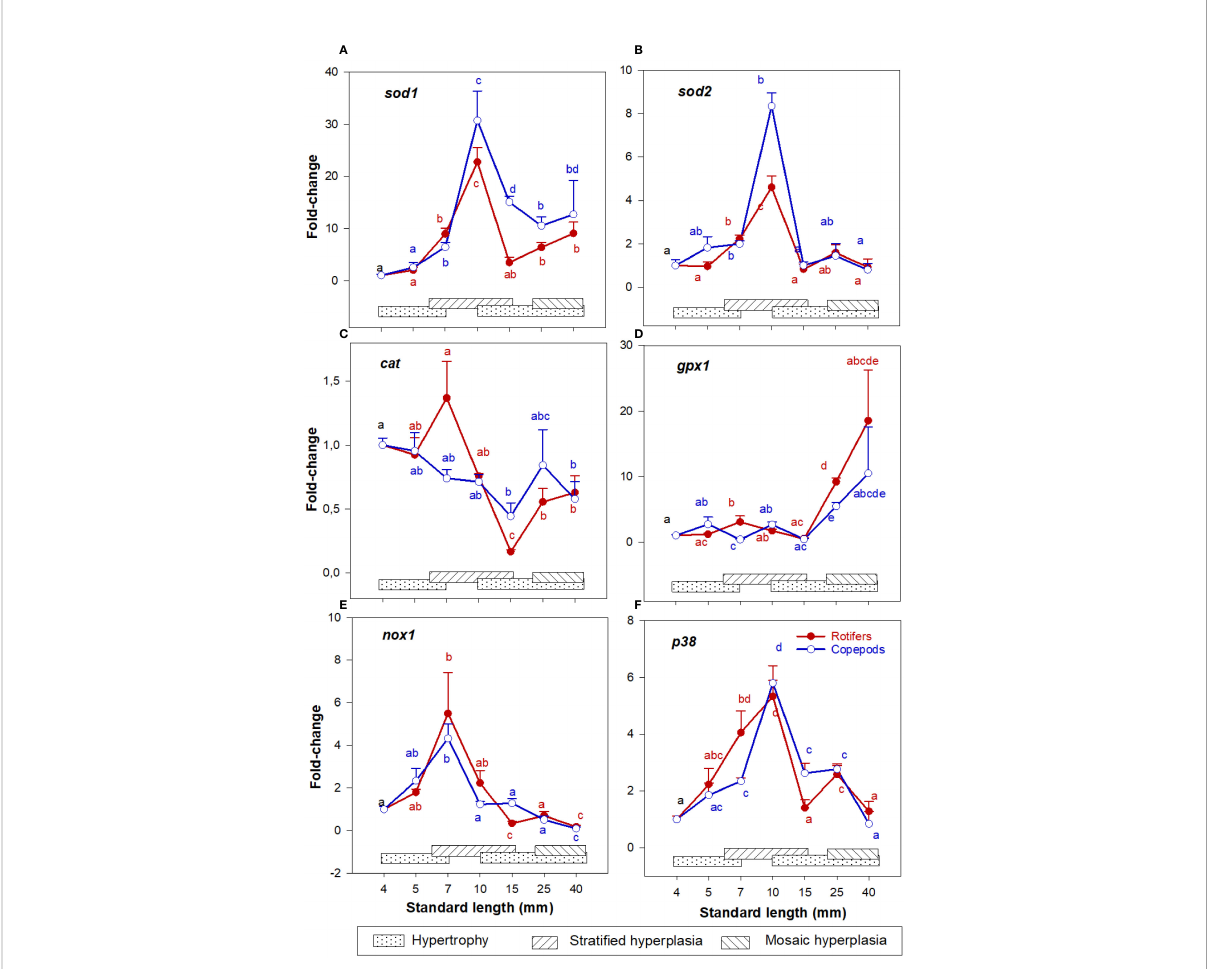
FIGURE 6 Gene expression (qPCR) of (A) sod1 ; (B) sod2 ; (C) cat ; (D) gpx1 ; (E) nox1 ; and (F) p38 in skeletal muscle tissue of Atlantic cod larvae fed rotifers/ Artemia (red line) or Copepods (blue line) in relation to muscle growth dynamics. Muscle growth dynamics (hypertrophy and strati fi ed and mosaic hyperplasia) in relation to body size is indicated by horizontal bars (data from Vo et al., 2016). Data are given as mean (n= 4 ± SEM) and values are expressed as fold change compared to day 4 post-hatch. Different letters indicate signi fi cant differences between the larval stages and treatments (P <